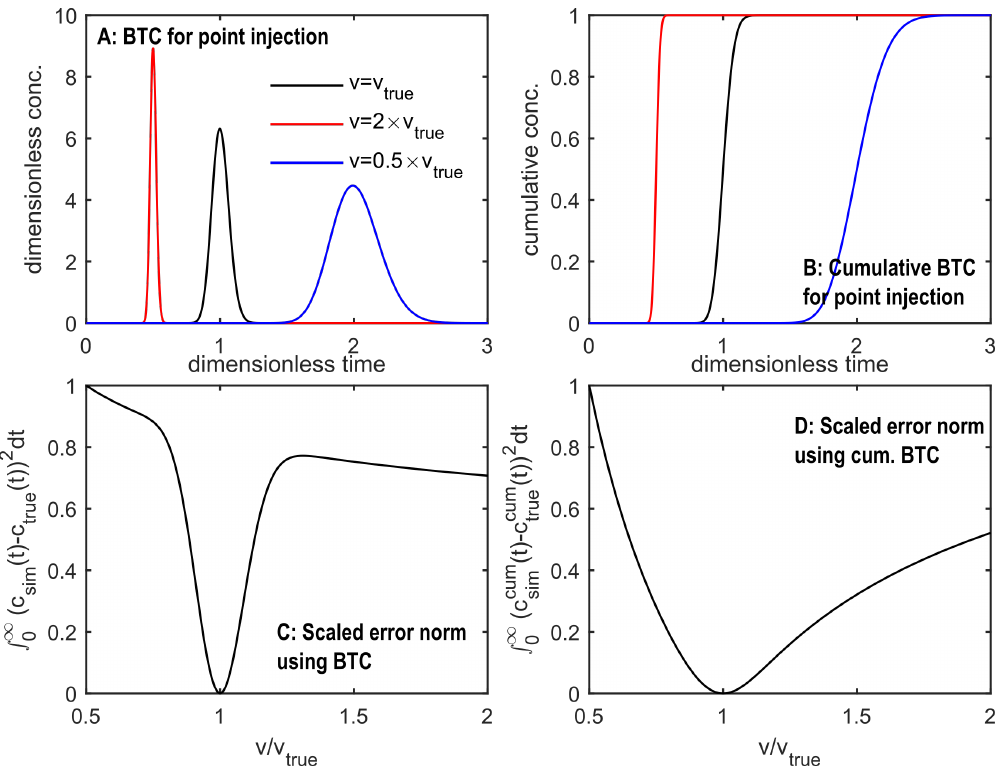
Figure 4. Sensitivity of a pulse-related breakthrough curve ( A ) and the corresponding time-integrated signal ( B ), with respect to groundwater velocity. ( C ): error norm as a function of velocity, between the reference and simulated breakthrough curves. ( D ): error norm as a function of velocity, between the reference and simulated cumulative breakthrough